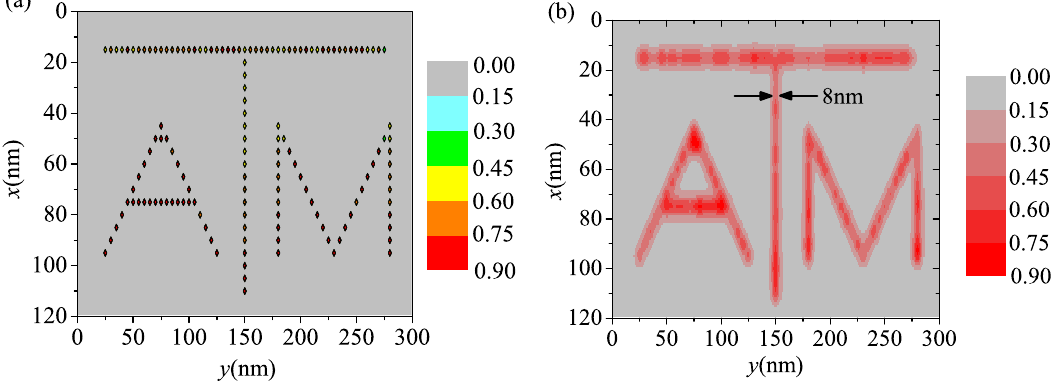
Figure 3. (Color online) Numerical simulation to write the Texas A&M University logo into a two-dimensional area using MRL. ( a ) The spatial distribution of the probability that the spins are prepared in the bright state; ( b ) The FRET efficiency on the substrate surface when the readout contrast is